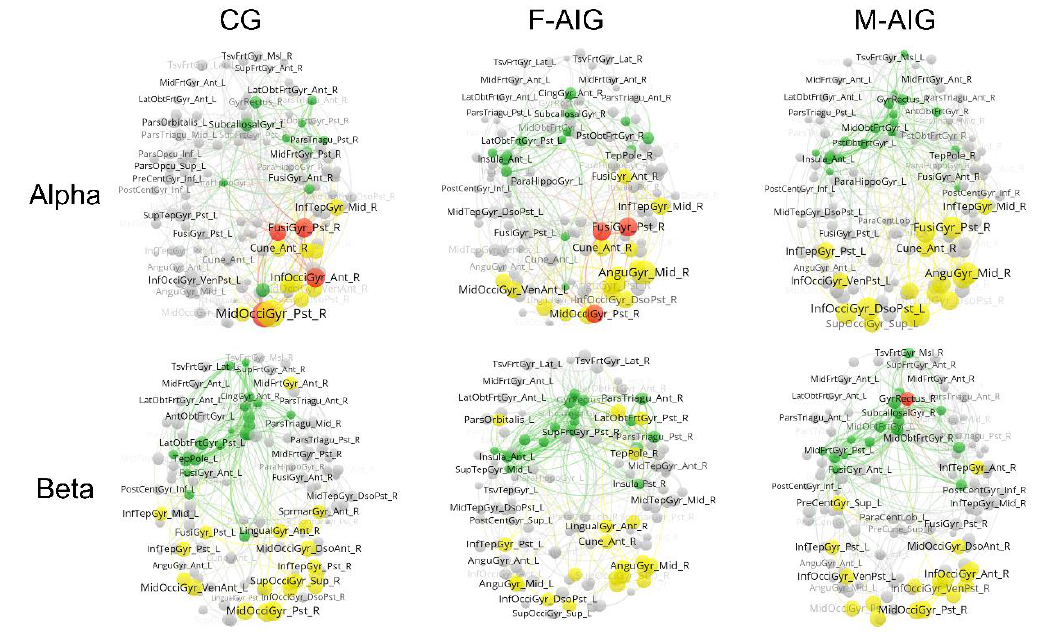
Figure 7. Distribution of hot hubs (in red), non-hub hot spots (in yellow), cold hubs (in green), and non-hub cold nodes (in grey) in brain function networks of three groups. All nodes are classified into four types: hot hubs (in red), non-hub hot spots (in yellow), cold hubs (in green), non-hub cold nodes (in grey). Node size is proportional to the ERSPs, and the view of the figure is top-down. M-AIG: male action observation-induced group; F-AIG: female action observation-induced group; CG: control group.